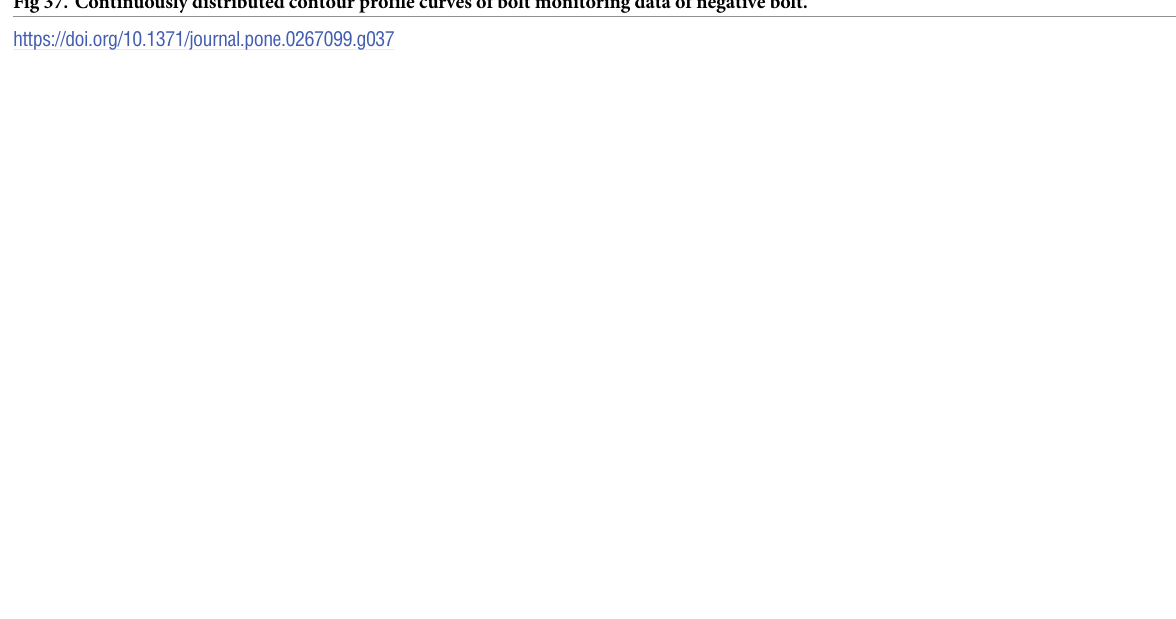
PLOS ONE | https://doi.org/10.1371/journal.pone.0267099 April 28,